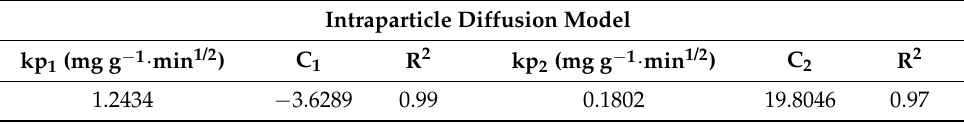
Figure 8. Diagram of the intraparticle diffusion model for the adsorption of Cl − on the LDO. Table 4. Parameters of the intraparticle diffusion model.